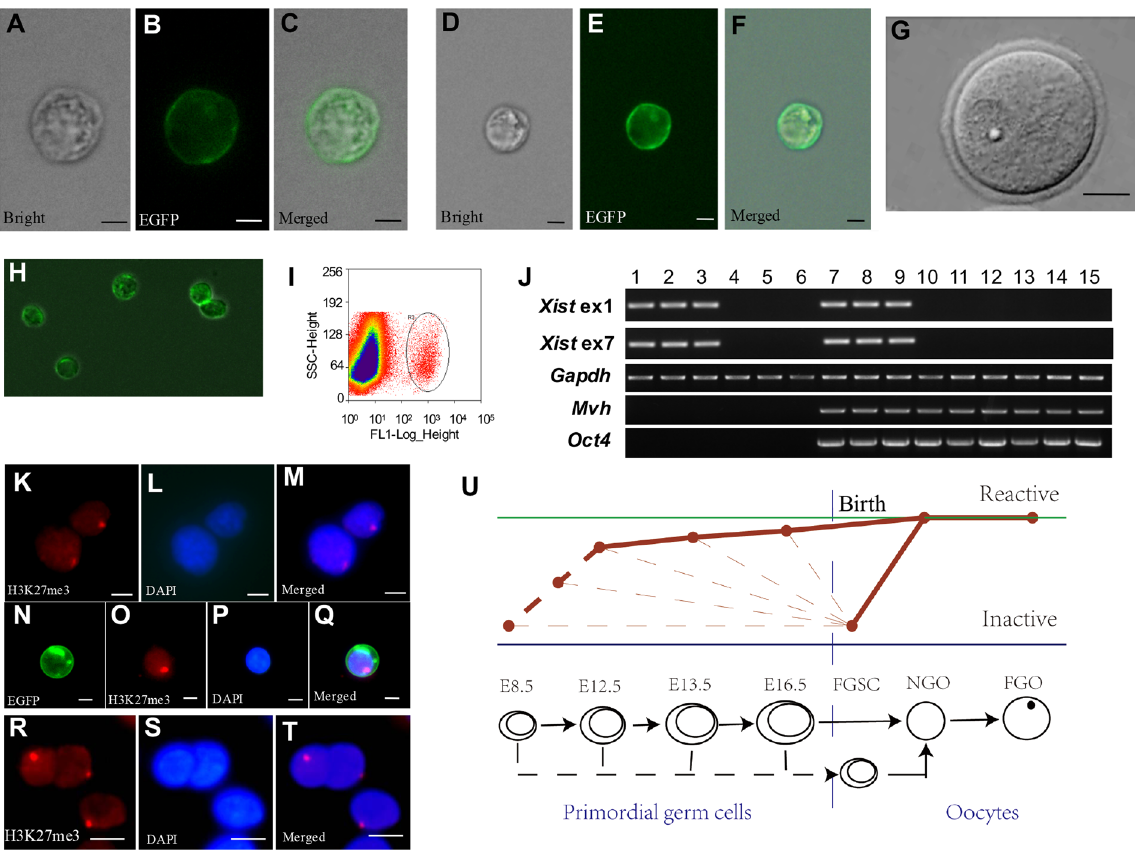
Figure 1. The X chromosome undergoes a process of reactivation in female germ cells from FGSCs to oocytes. ( A – C ) Representative morphology of Mvh positive cells from XX genital ridges after E12.5 under light microscopy and fluorescence microscopy. ( D – F ) Representative images of Mvh positive cells from ovaries of 3–5 days old Mvh-GFP transgenic mice (Mvh-cre; ROSA mT/mG mice) under light microscopy and fluorescence microscopy. ( G ) Representative morphology of oocytes. ( H ) Representative view of merger for Mvh positive cells under light microscopy and fluorescence microscopy after purification with FACS.( I ) An example for FGSC purification with FACS. ( J ) Single cell RT-PCR analysis of Xist , Mvh and Oct4 . Lane 1–3, female Tail fibroblasts (positive control); lane 4–6, male tail fibroblasts (negative control); lane 7–9, FGSCs; lane 10–12, NGO; lane 13–15, FGO. Full-length gels are presented in Supplementary Fig. S15. ( K – M ) FGSC cell line showed the expected frequencies of the Xi-like enrichment for H3K27me3. Cells were counterstained with DAPI. ( N – Q ) Fresh isolated FGSCs showed the expected frequencies of the Xi-like enrichment for H3K27me3. Cells were counterstained with DAPI. ( R – T ) Female tail fibroblasts showed the expected frequencies of the Xi-like enrichment for H3K27me3 (positive control). Cells were counterstained with DAPI. ( U )Schematic illustration of the process of reactivation in germ cell development: the FGSCs, PGCs and oocytes formed a process from X inactivation to X reactivation in germ cell development. The solid line shows the process we determined, while the dotted line shows the process we do not test. The slim dotted line indicated that early germ cells contain the cells entering meiosis and very small amount of the cells not entering meiosis (or precursors of FGSCs). For ( A – F , H , K – T ), Scale bar = 5 μ m, for G, Scale bar = 20 μ m. The experiments were conducted three